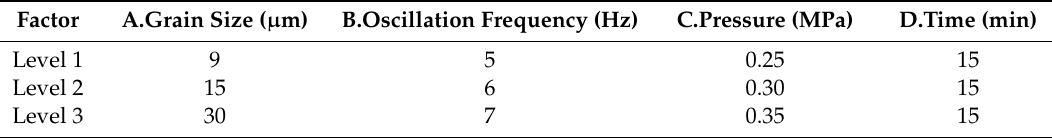
Table 1. Parameters of Orthogonal